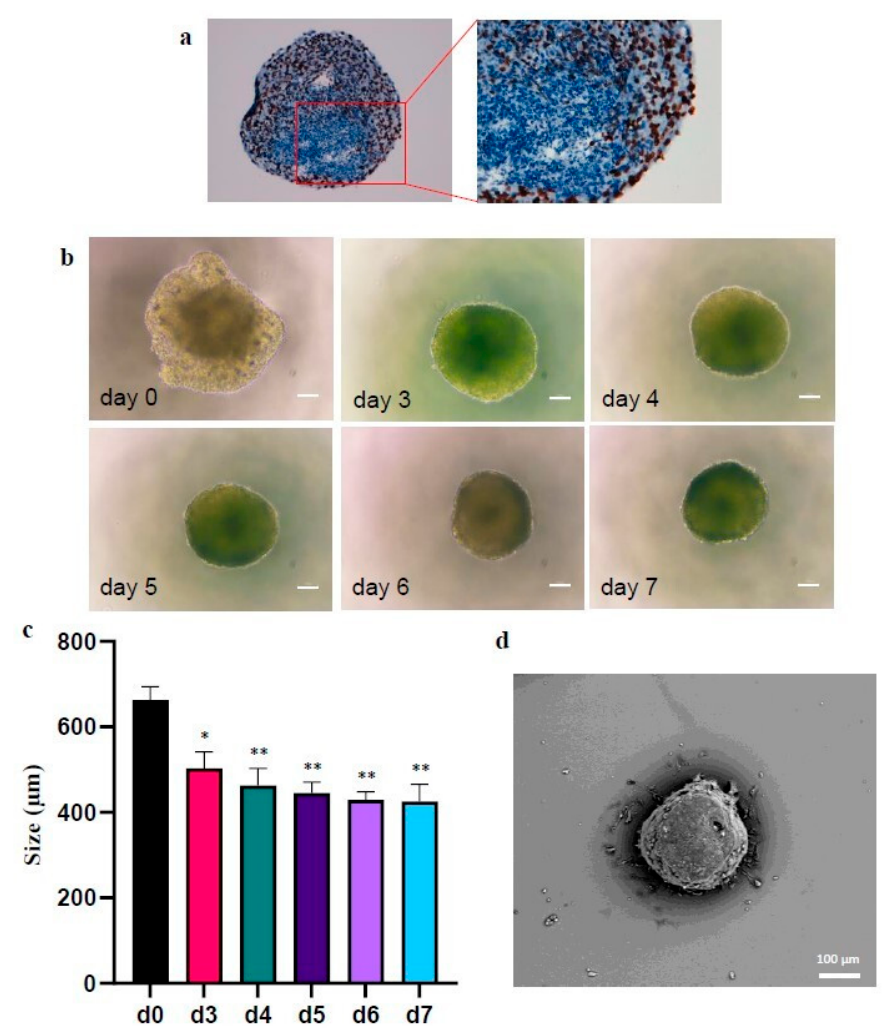
Figure 2. Morphology and size of a CABA I representative spheroid. ( a ) Ki67 staining of a representative spheroid (conventional immunohistochemical staining procedure). 20 × magnification for the left image, 40 × magnification for the right image; ( b ) Images of a representative CABA I spheroid at d0, d3–d7 from the transfer onto low attachment surface; the size bar is 100 μ m. ( c ) Graph reporting the mean size (mean of two repeated measures of diameter) of the representative spheroid at days 0–7 (mean ± SD) (* p < 0.05; ** p < 0.01). ( d ) SEM image of a representative CABA I spheroid; the size bar is 100 μ m.